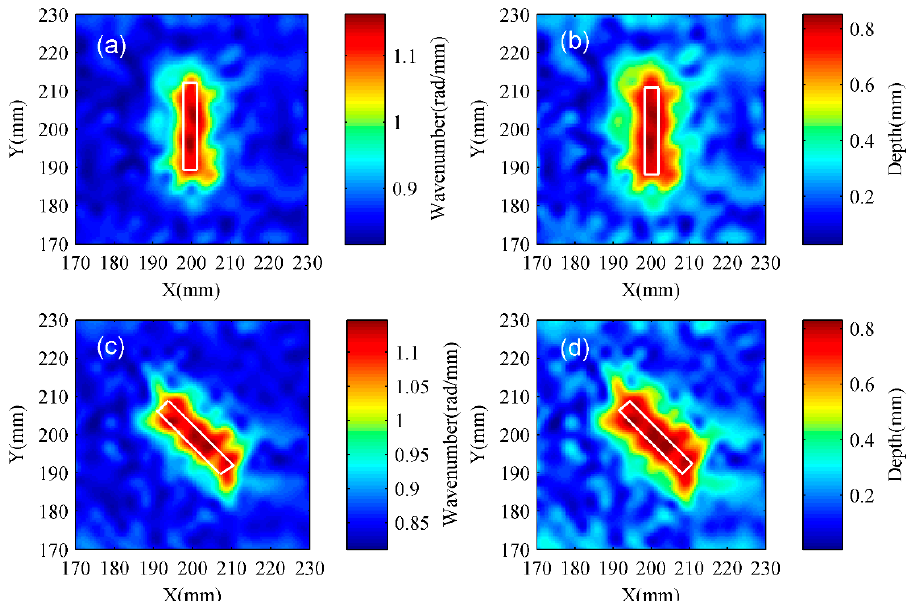
Figure 20. Experimental results of Case 8 and Case 9. ( a ) Wavenumber distribution of Case 8; ( b ) depth distribution of Case 8; ( c ) wavenumber distribution of Case 9; ( d ) depth distribution of Case 9. The white circle represents the actual location of the damage. The actual depth of the defect is 1 mm.